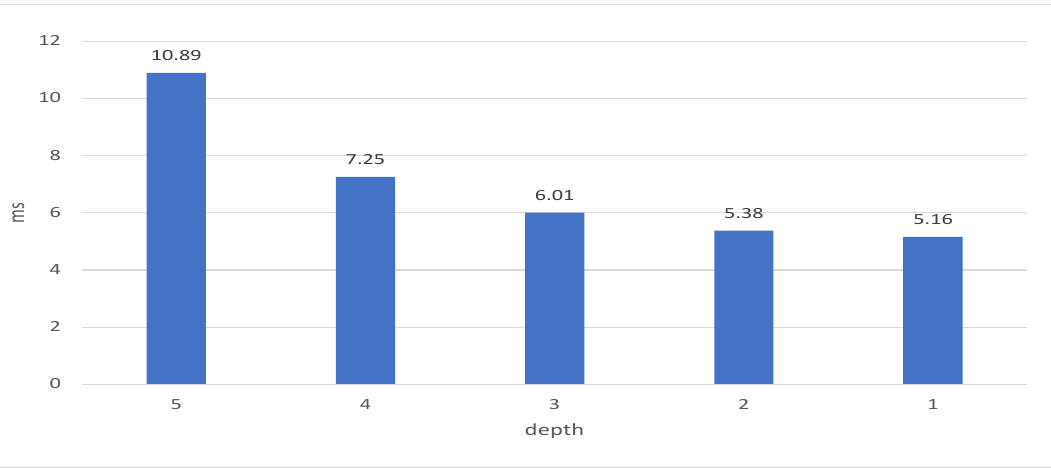
Figure 10. The cost of tip select by different traversal depths.